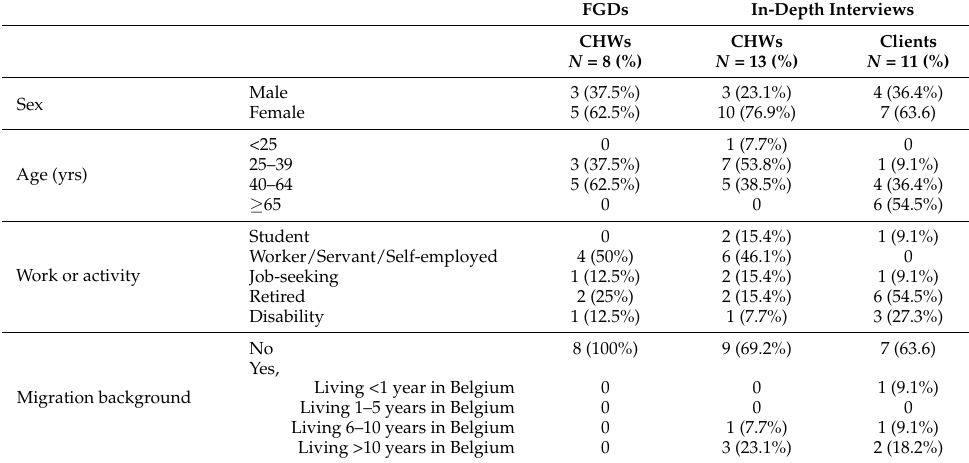
Table 1. Sociodemographic characteristics for participants of focus group discussions and in-depth interviews. FGDs (focus group